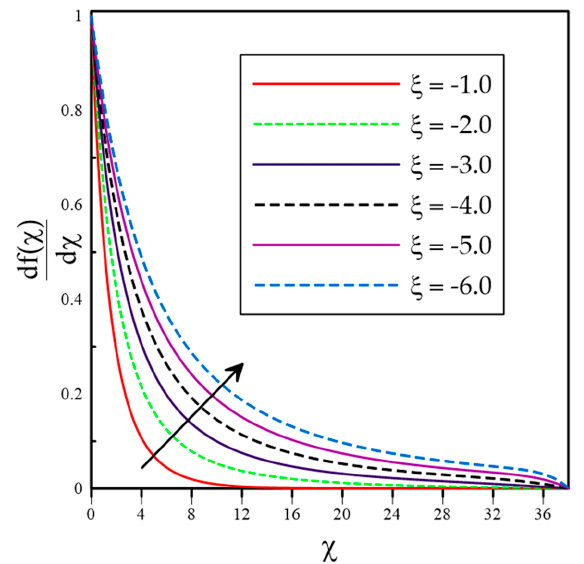
Figure 3. Velocity profile against the various values of injection parameter when p =